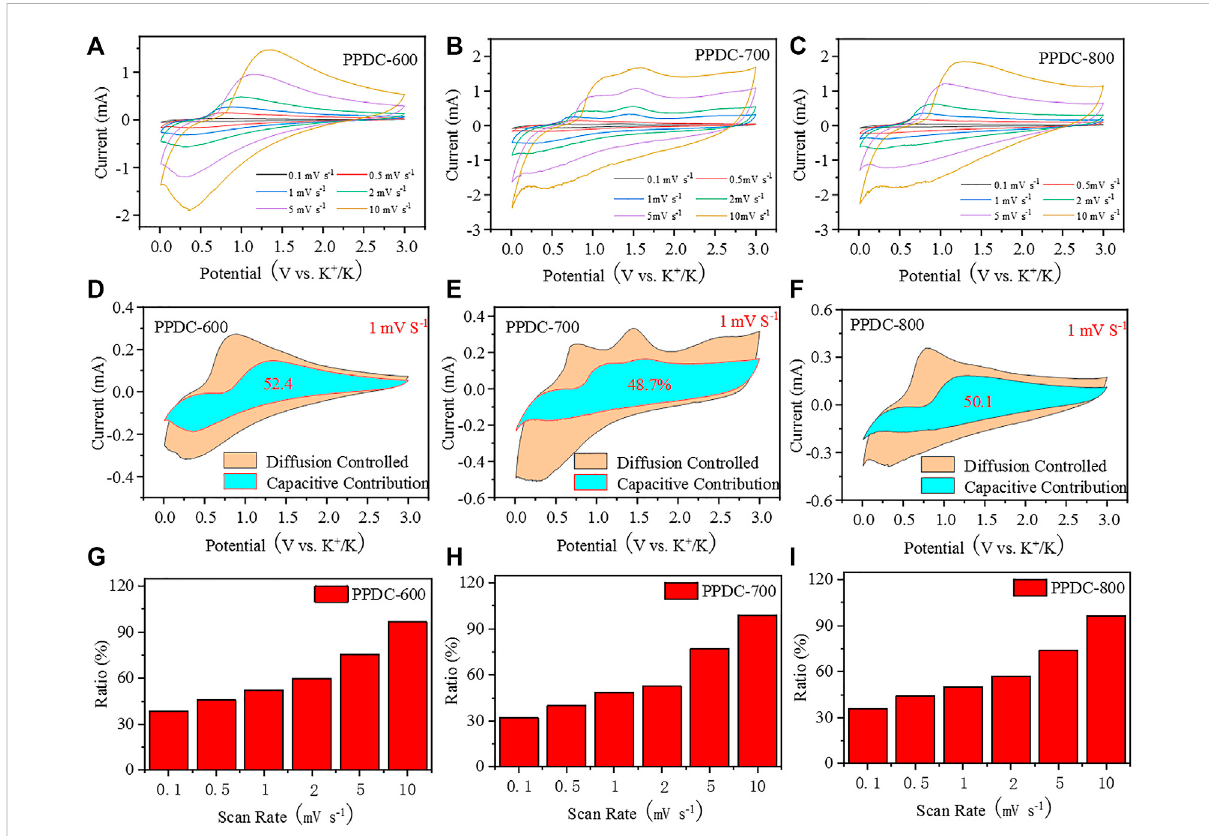
FIGURE 4 Kinetic analysis of the PPDC electrodes. CV curves of (A) the PPDC-600, (B) the PPDC-700 and (C) the PPDC-800 at various scan rates of 0.1 – 10 mV s − 1 ; Contribution of the surface process at scan rate of 1 mV s − 1 in (D) the PPDC-600, (E) the PPDC-700 and (F) the PPDC-800; Contribution of the surface process in (G) the PPDC-600, (H) the PPDC-700 and (I) the PPDC-800 at different scan